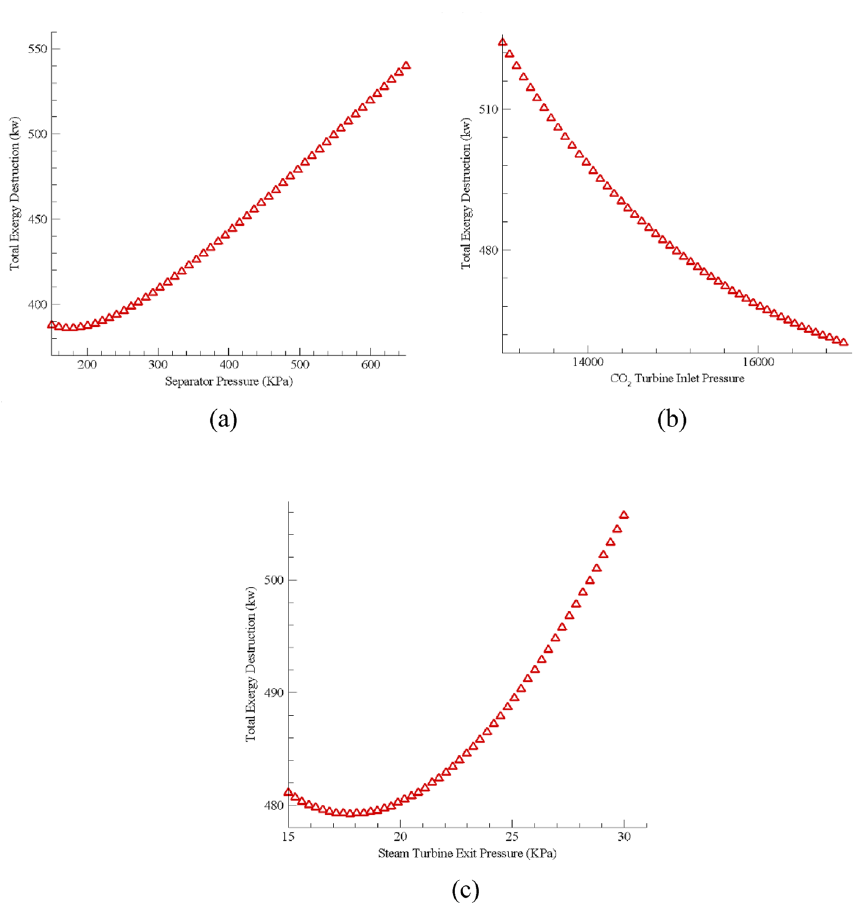
Fig. 7 Exergy destruction changes of the total system with respect to the a separator pressure b CO 2 turbine inlet pressure c steam turbine exit pressure